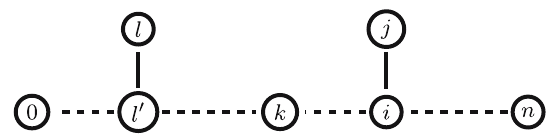
Figure 11: Minimum subgraph of C containing vertices { } l j k n 0, , , , , when > l n